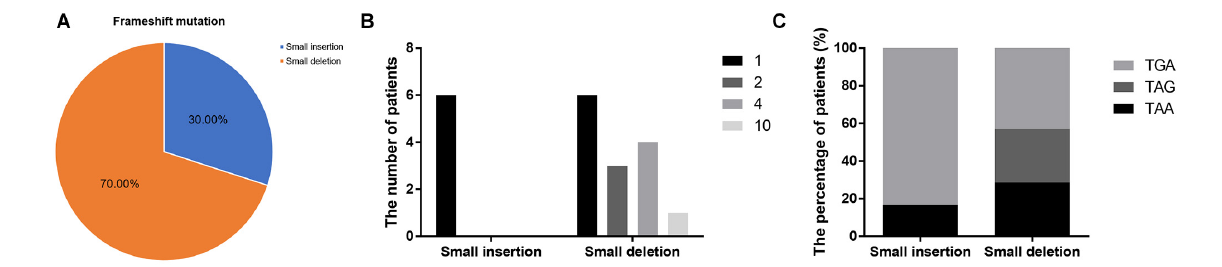
FIGURE 5 | Information regarding small insertions and deletions in frameshift mutations. (A) Proportions of small insertions and deletions in frameshift mutations. (B) The number of deleted or inserted bases in small insertions and deletions. (C) Proportions of first hidden premature termination codons in small insertions and deletions.